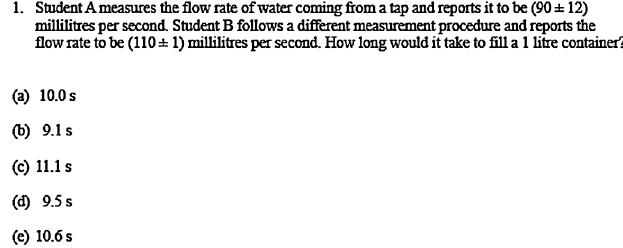
function.FIG. 1. Item 1 assesses whether or not students know that the measurement with the larger uncertainty should carry less weight in the answer to the question. A weighted mean could be used, but the difference in uncertainty is large enough that a student could also arrive at the correct answer by simply discarding the poorer measurement. The distractors include (a) use of the unweighted mean, (c) discarding the more precise measurement, (d) using a value of 105 : 5 mL = s , which is the value centered in the gap between 90 þ 12 mL = s and 110 (cid:1) 1 mL = s , and, about whether students worry about systematic error, and in the method of student B, in particular. This concern reflects a particular kind of expert point of view, but is not one that we believe to be valid from the student perspective. (Over the course of our interviews, we have not encountered any evidence of a student worrying about systematic error for this question; that is not to imply that it does not happen, only that it does not appear to be common.) FIG. 2. Item 2 probes a student’s judgment of an appropriate use of significant figures. The distractors include (a) the product with no rounding of significant figures, (b) the product rounded to the same precision as the multiplicand, and (d) the product rounded to an intermediate precision.